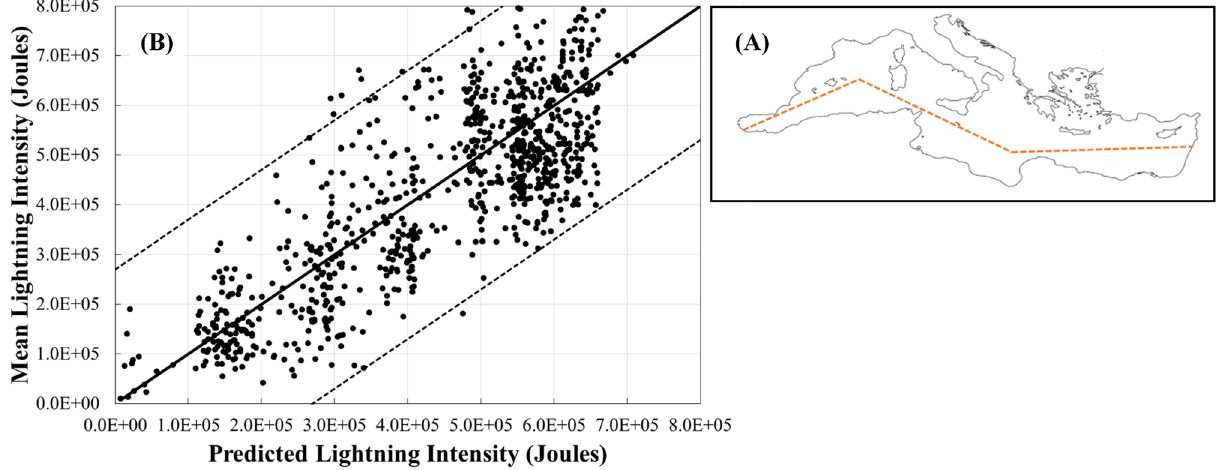
Figure 3. Comparison of mean lightning intensities along the Mediterranean sea zonal profile ( A ), determined from the WWLLN measurements during the winter months (December, January and February) over the period 2009–2021, and predicted lightning intensities using a MLE as a function of the surface water S, pH and TA/S from the Copernicus dataset for the corresponding months over the same period ( B ). Where, Predicted Lightning Intensity = − 7,135,883 (± 771,242)·pH + 37,662 (± 9328)·S + 437,509 (± 22,667)·(TA/S) + 27,233,671 (± 5,371,319) (n = 943; R 2 = 0.61; p < 0.0001). The numbers in parentheses in the equation, are the standard errors of the parameter coefficients and the intercept. The regression line is represented by the continuous black line and the dashed black lines represents the upper and lower 95% confidence interval